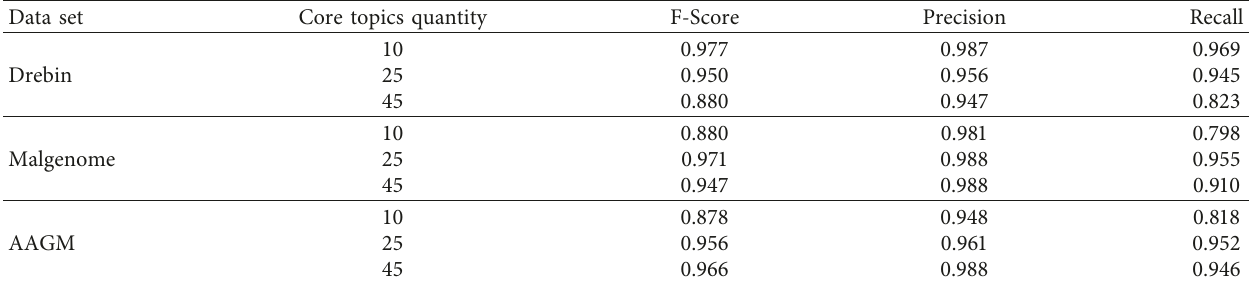
Table 11: Performance outcomes for distinct topics quantity.